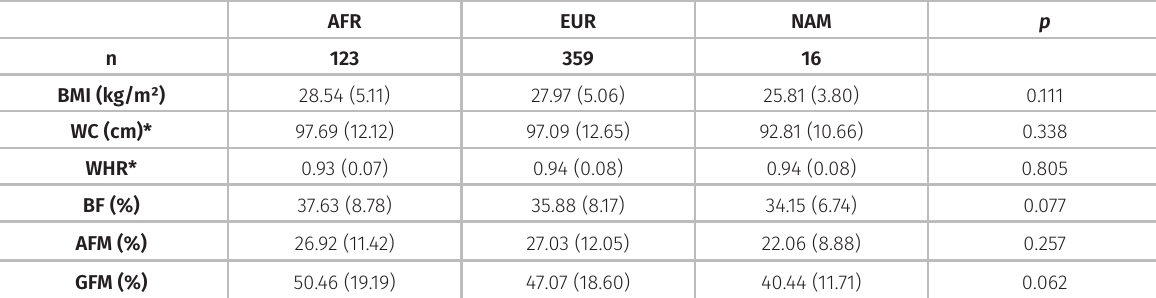
Table II. Means, standard deviations and p -values of the obesity-related parameters for each genomic ancestry, as well as the frequencies of each ancestry in the population